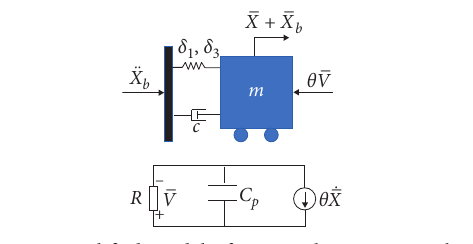
Figure 1: A simplified model of a piezoelectric energy